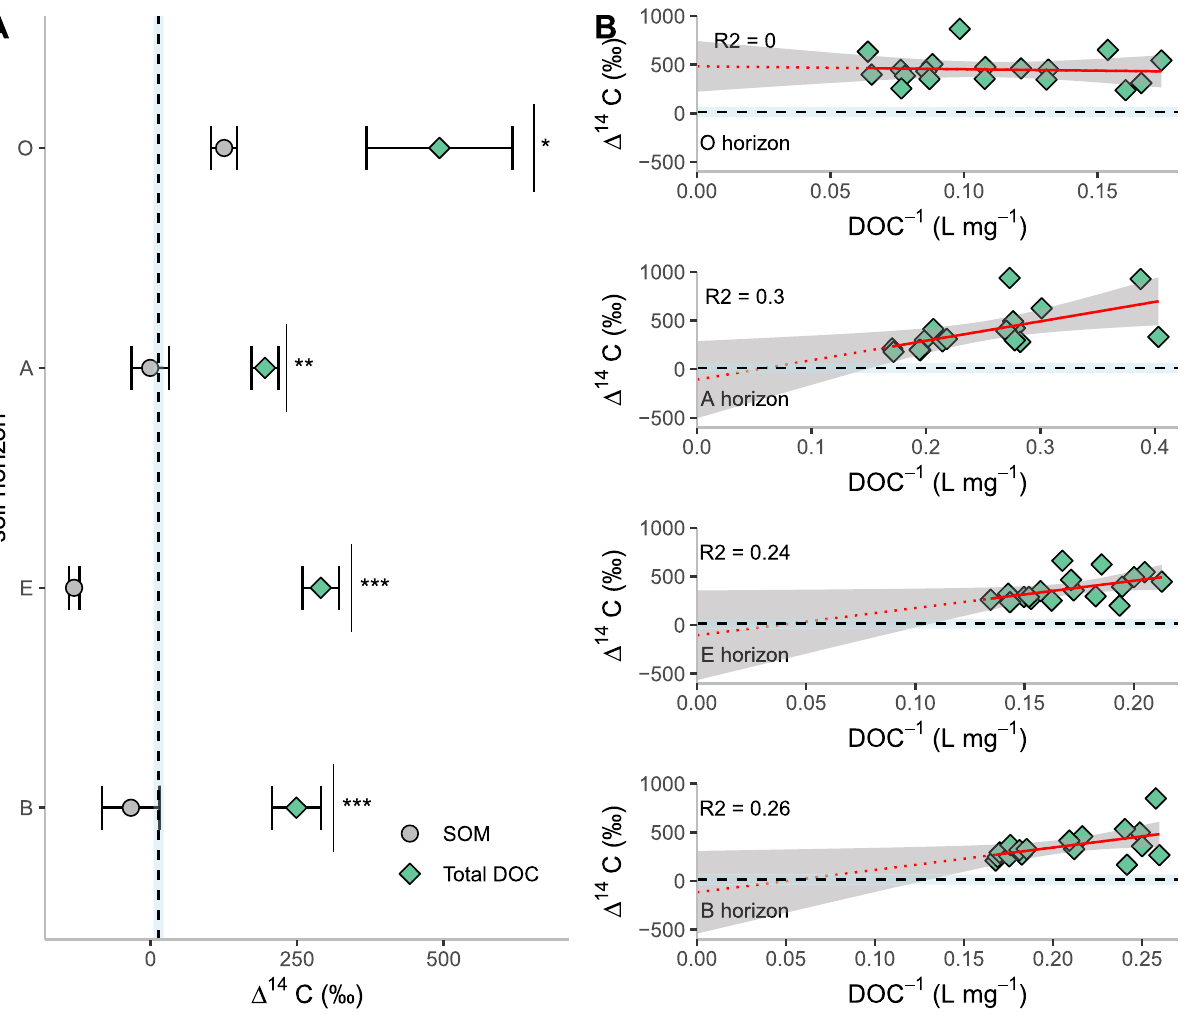
Figure 2. ( A ) The Δ 14 C signature of soil organic matter (SOM) and WEOC at time point 0, significance is given by * p < 0.05, ** p < 0.005 and *** p < 0.001. ( B ) Keeling plots depicting the Δ 14 C signature as function of the inverse DOC concentrations. Note the y-axis intercepts, which represent the isotopic signatures of the degraded DOC. The straight dashed line represents the most current (2015) atmospheric Δ 14 C value of CO 2 . The 95% interval is given in